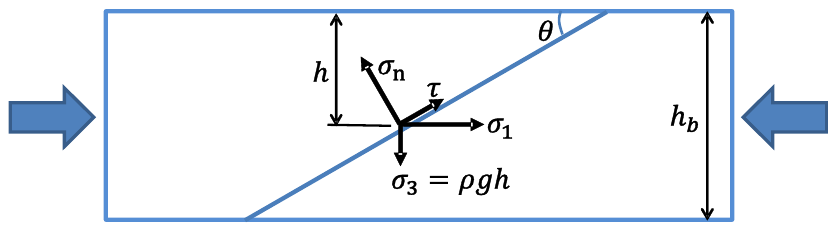
Figure 4. A simple mechanical model of the thrust fault.